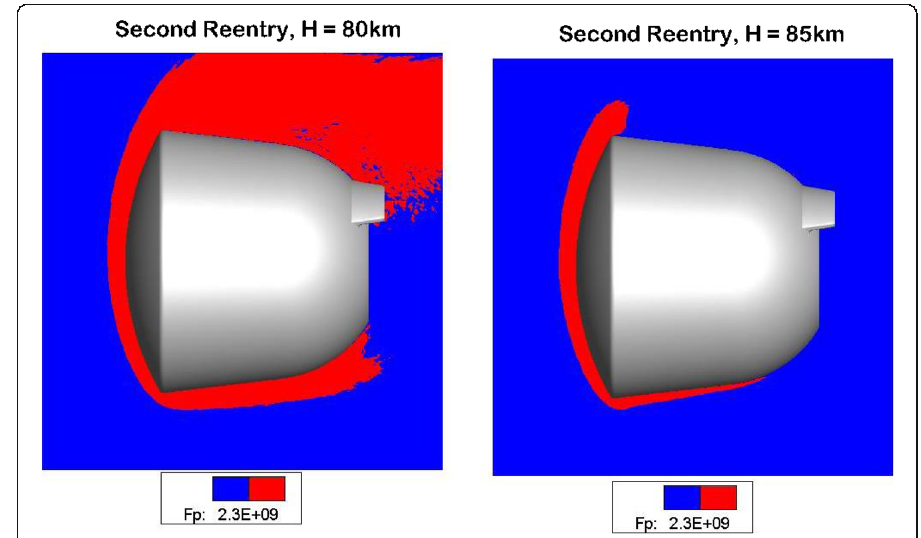
Fig. 22 The corresponding electromagnetic wave frequency of the lunar exploration type capsule at different altitudes for the second reentry (Unit: Hz)